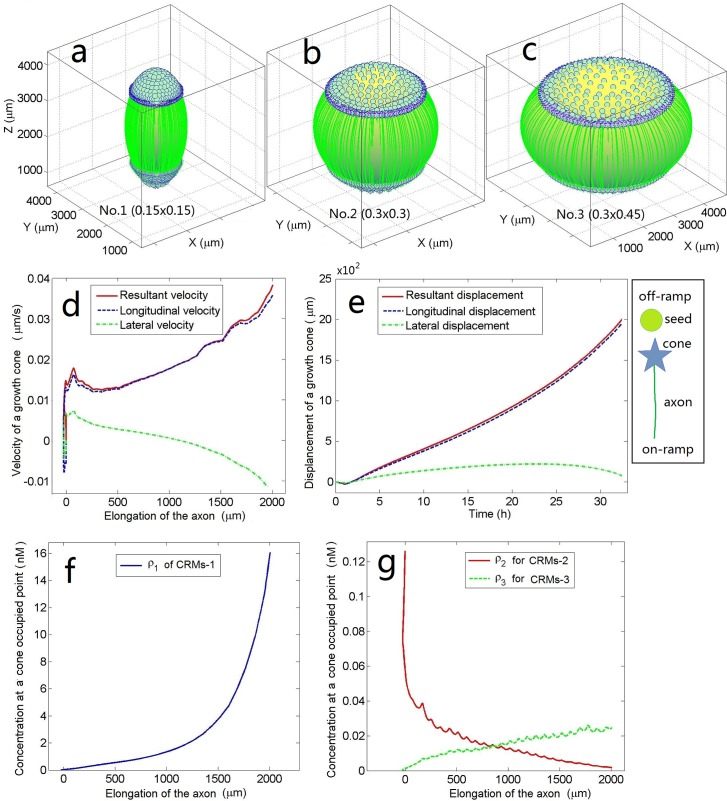
Three test scaffolds of different lateral sizes and some products.a)–c)The scaffolds and attached regenerated axons are separated and extracted from the models after calculation. In scaffolds No. 1, No. 2, and No. 3, the lateral semi-axis is ra = 0.15, 0.3, and 0.45 (or 0.75, 1.50, and 2.25 mm), respectively. The longitudinal semi-axis is rb = 0.3(or 1.5 mm) in all cases, and the number of severed axons is NA = 300 in each calculation. The green bubbles with number NT = 300 and density γ1 = 0.1 μm−2 embedded in the upper part (or the caudal/off-ramp) of each scaffold represent the coarsening point sources (or target cells) for CRMs-1 (two other seed types with densities γ2 = γ3 = 0.1 μm−2 also cover the whole surface of each scaffold but are not shown). The green longitudinal lines (slightly fascicled) stemming from the lower part (the rostral/on-ramp) of each scaffold represent the regenerated axons (numbering 0.78 NA, 0.7 NA, and 0.58 NA in a, b, and c, respectively, corresponding to axonal regeneration success rates of 0.78, 0.7, and 0.58, respectively). d)–g) Results related to a typical regenerating axon taken from the calculation of scaffold No. 1 (qualitatively similar results are obtained for the other two scaffolds). At the beginning, when the axon is at the on-ramp, its growth is unstable and some retraction is observed (d and e) because the concentrations of the positive factors CRMs-1 (f) and CRMs-3 are low (g; green), while those of the inhibitoryfactors are high (g; red). This situation is reversed as the axon approached the off-ramp.